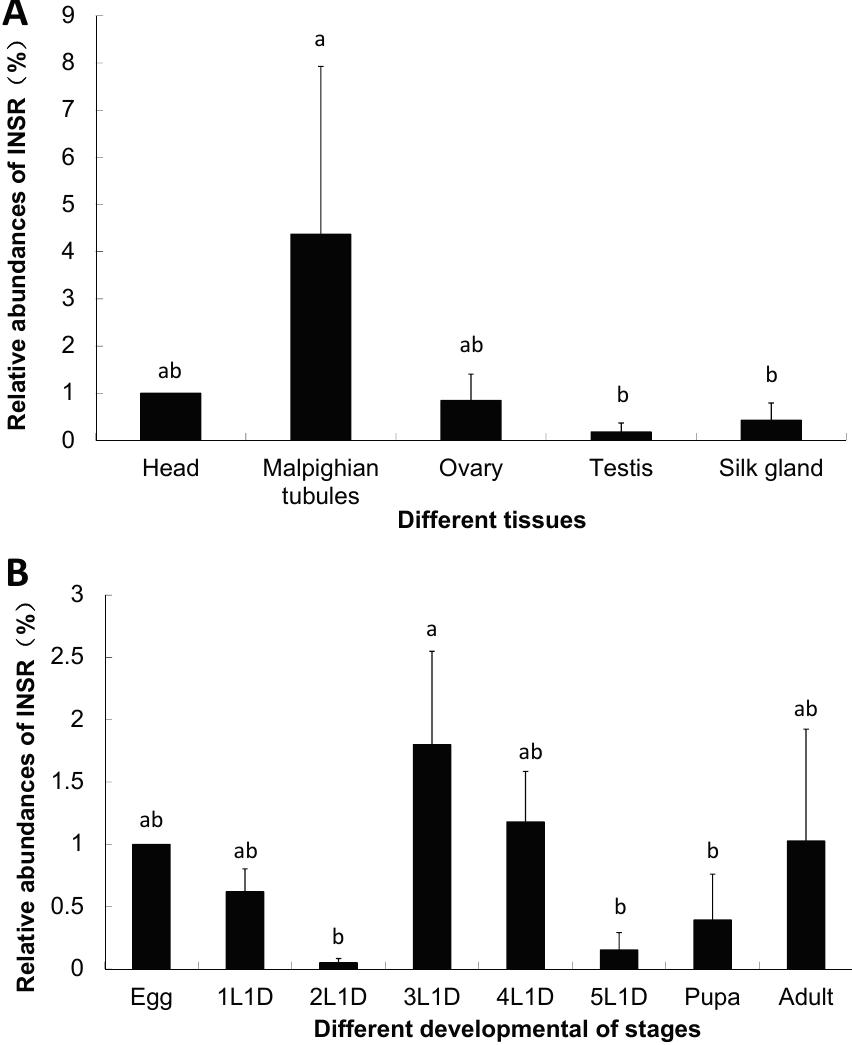
Figure 4. Relative abundance of Bm-INSR gene in different tissues and developmental stages. ( A ) different tissues; and ( B ) different developmental stages. 1L1D, 2L1D, 3L1D, 4L1D, 5L1D: First day of each instar (Tukey test, p < 0.05. “a” and “b”, same letters in figure differentiated no significantly, different letters differentiated significantly). The gene expression levels were examined using quantitative real time PCR. The gene RP49 was used as the internal